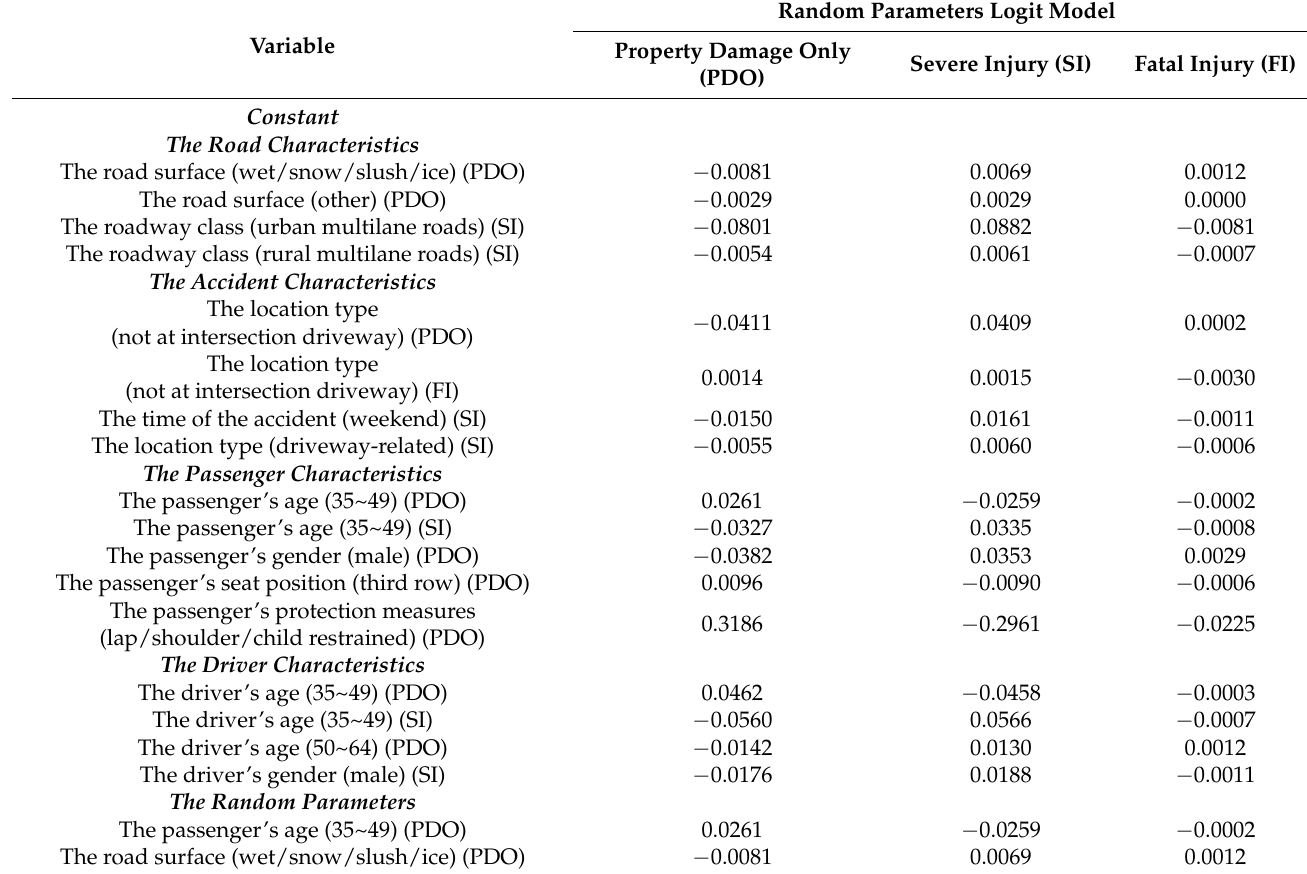
Table 7. The marginal effects of 2017 in daylight conditions with street lighting